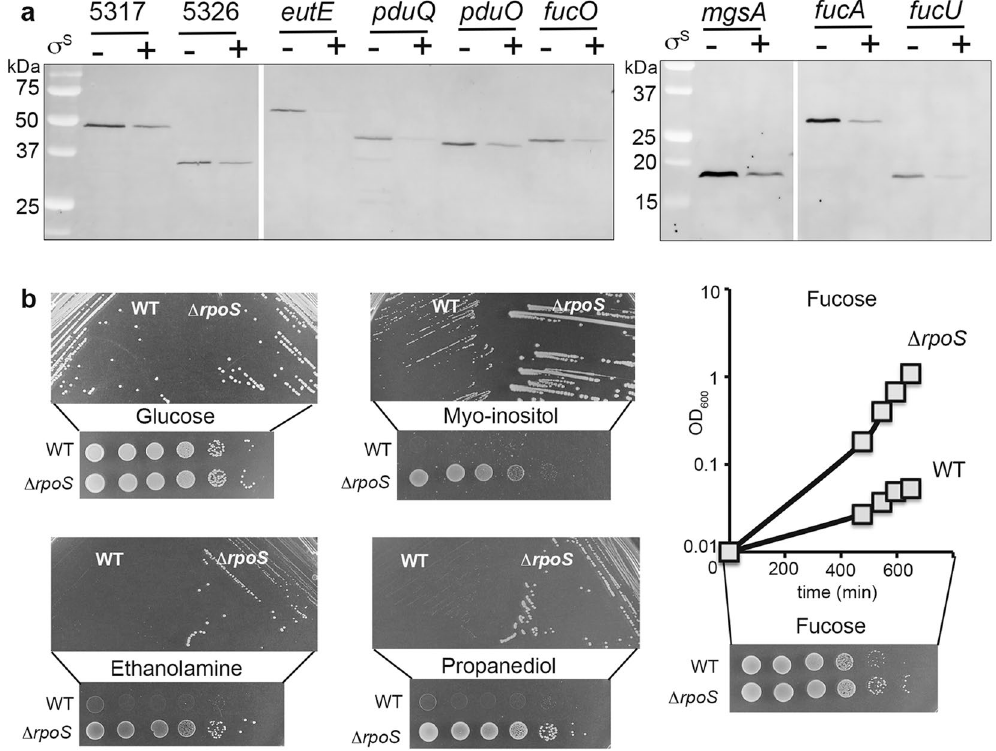
Figure 5. Physiological validation of σ S down-regulation of metabolic functions revealed by proteomic analyses. ( a ) Immunodetection of 3xFlag-tagged proteins of interest with an anti-Flag antibody in stationary phase (OD 600 of 4) LB cultures of the wild type and rpoS strains (VF6910 and VFC331). The amount of proteins in whole-cell lysates was determined and 20 μ g of total proteins were loaded in each slot. Reversible Ponceau staining of the membrane was used to check proteins transfer. Similar results were obtained in at least two independent experiments. ( b ) Effect of a Δ rpoS mutation on Salmonella growth at the expense of glucose, myo- inositol, propanediol, ethanolamine and L-fucose as sole carbon source. For growth assays on plates, stationary phase cultures in LB of the wild type (WT, VF6910) and Δ rpoS (VF8158) strains were washed and spotted onto plates as indicated in Fig. 3. The bacterial suspensions were also streaked on plates to assess colony size. The bacterial growth of the wild-type strain and Δ rpoS mutant was also compared in liquid medium containing L-fucose. Stationary phase cultures in LB were washed, resuspended in PBS 54 to an OD 600 of 1.0, and bacteria were inoculated to minimal medium containing L-fucose at an initial OD 600 of 0.01. The growth phase was determined by measuring culture turbidity at an optical density of 600